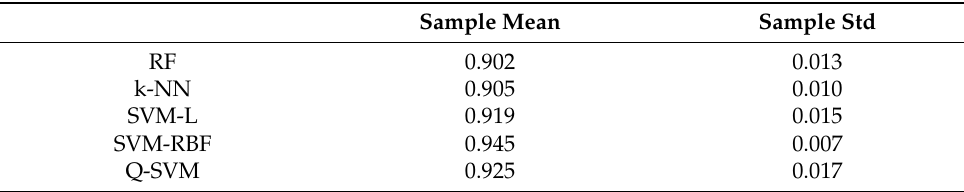
Table 8. Test accuracy sample mean and standard deviation for 10 models using 19 latent space AE. Sample Mean Sample Std